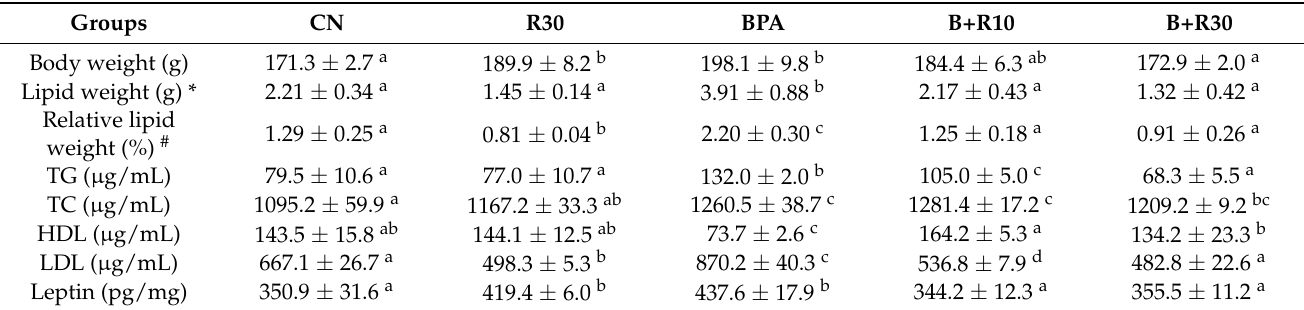
Table 1. Body weight, lipid weight, and plasma biochemical parameters of female offspring